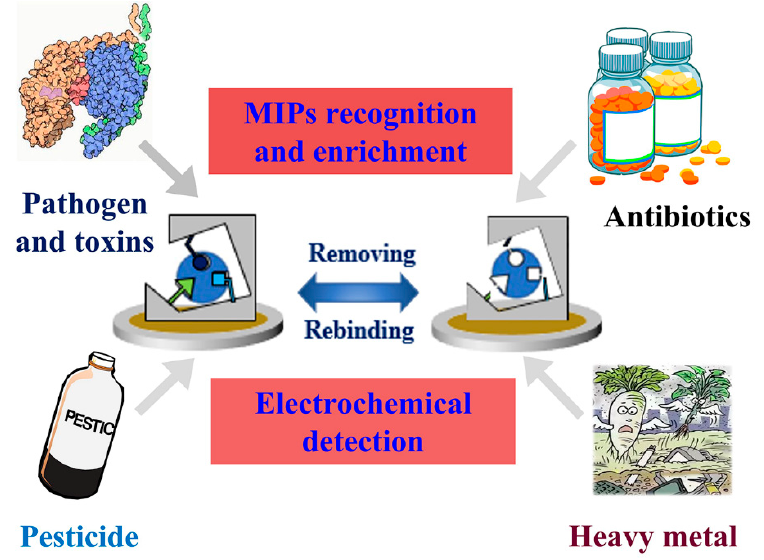
Figure 4 . Schematic presentation of MIECs in the applications of food and drug safety detection. Figure 4. Schematic presentation of MIECs in the applications of food and drug safety